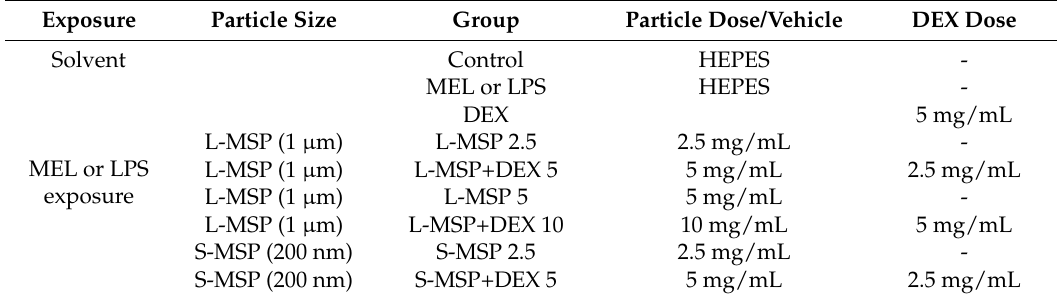
Table 1. Groups and experimental